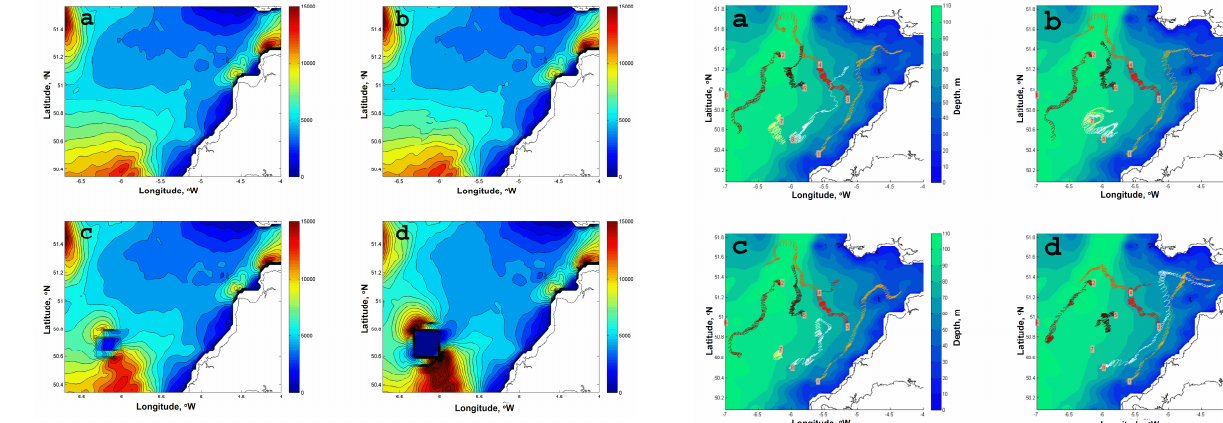
Table 1. Travel distance by Lagrangean floats over 30 days.